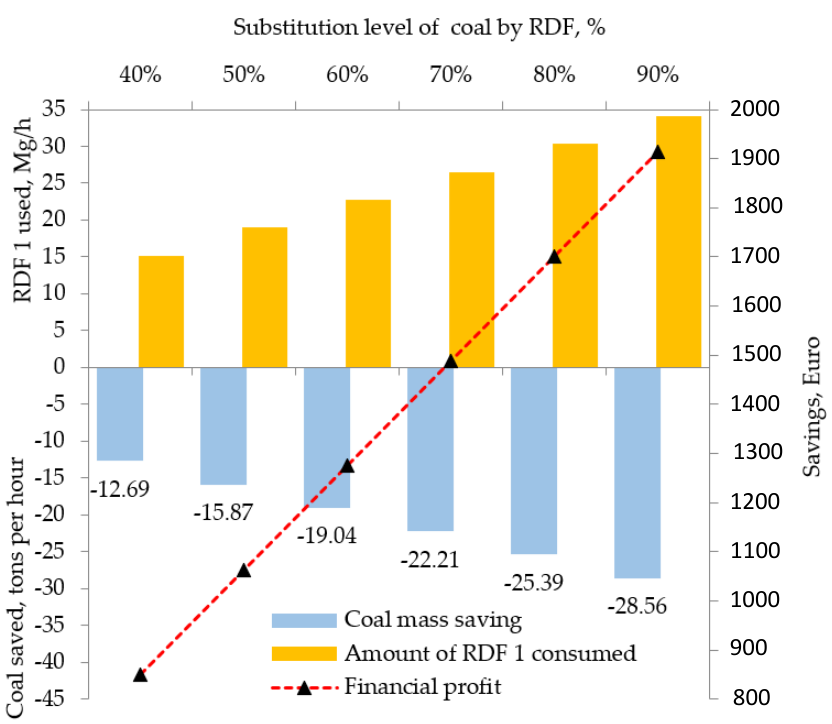
Figure 4. The coal and RDF 1 consumption balance for two- component blends (Table 1).